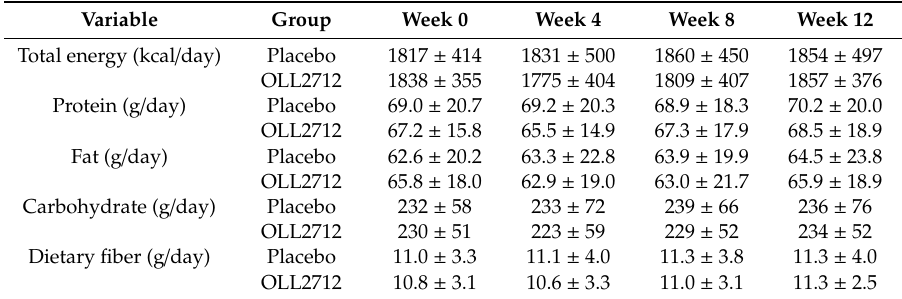
Table 2. Daily nutrition